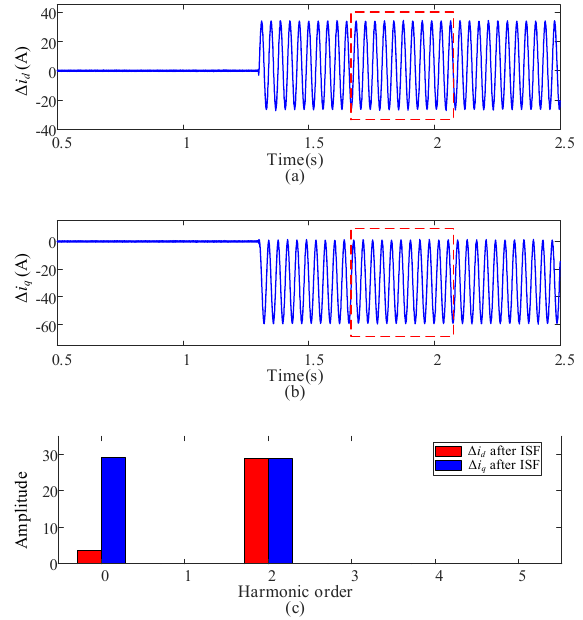
Figure 7. Simulation results of current residuals. ( a ) d -axis current residual; ( b ) q -axis current residual; ( c ) spectrum of current residuals after ISF.